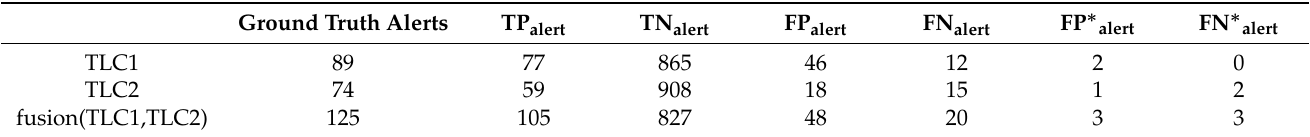
Table 5. Ground truth alerts, TP alert , TN alert , FP alert , FN alert , FP ∗ alert and FN ∗ alert obtained from all grids and priors, on single cameras ( TLC1 , TLC2 ) and their fusion (fusion(TLC1,TLC2)). Ground Truth